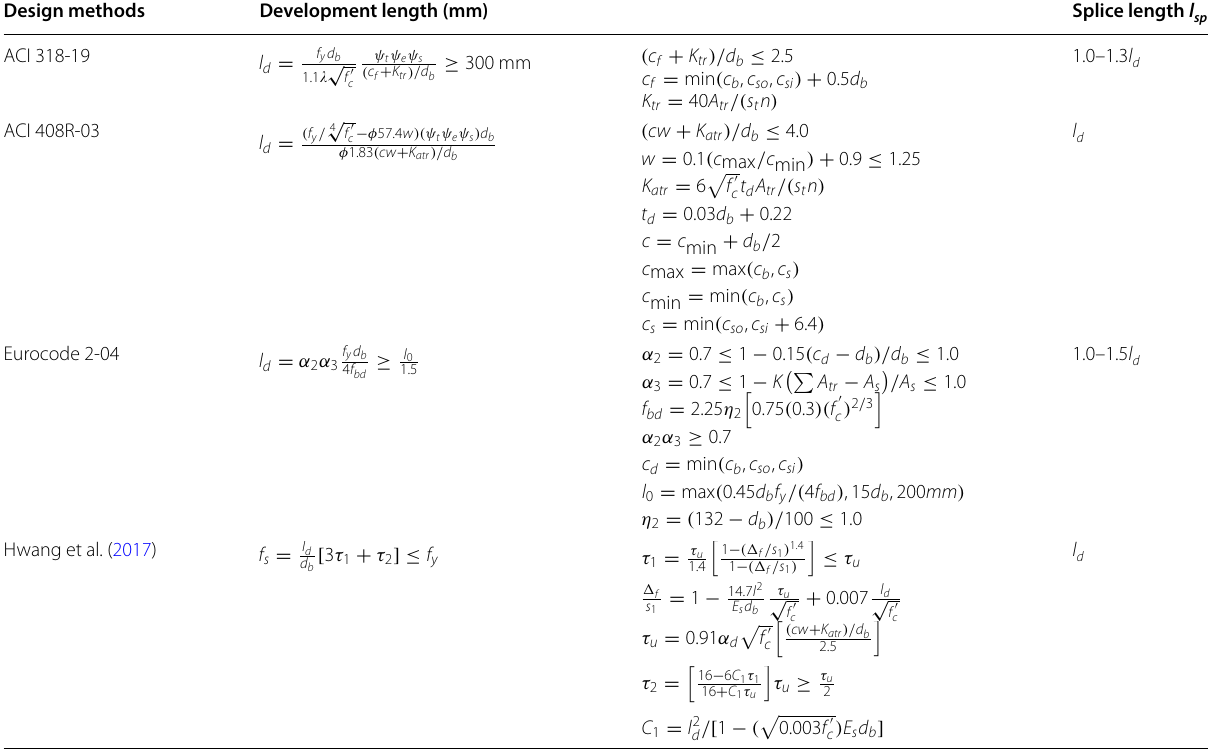
Table 6 Bar development length under static load.